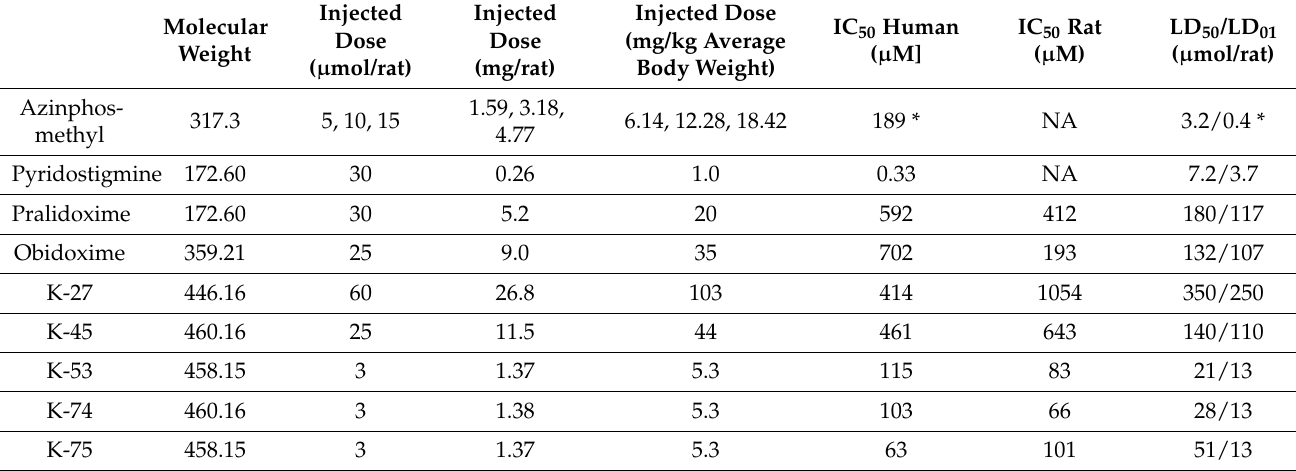
Table 4. Molecular weights, dosages, cholinesterase (AChE) inhibition, and LD values of the compounds administered. Column 2 lists their molecular weights, columns 3–5 the injected doses. Values are given in µ mol/animal (column 3), in mg/animal (column 4), and in mg/kg average body weight (column 5). Column 6 lists their concentration necessary to inhibit 50% of human red blood cell AChE activity (IC 50 ), column 7 the IC 50 for AChE inhibition determined in rat blood [61], and column 8 their LD 50 and LD 01 values for intraperitoneal (i.p.) application in rats [18]. The azinphos-methyl dose injected i.p. ranges from 5 µ mol ≈ LD 75 (first value) to 15 µ mol ≈ LD 100 (third value); the dosage of the compounds administered prophylactically (pyridostigmine, pralidoxime, obidoxime, K-27, K-48, K-53, K-74, K-75) before azinphos-methyl exposure was approximately 1 of the LD 01 . * Compound must be metabolized to bioactive oxon form. NA: not 4